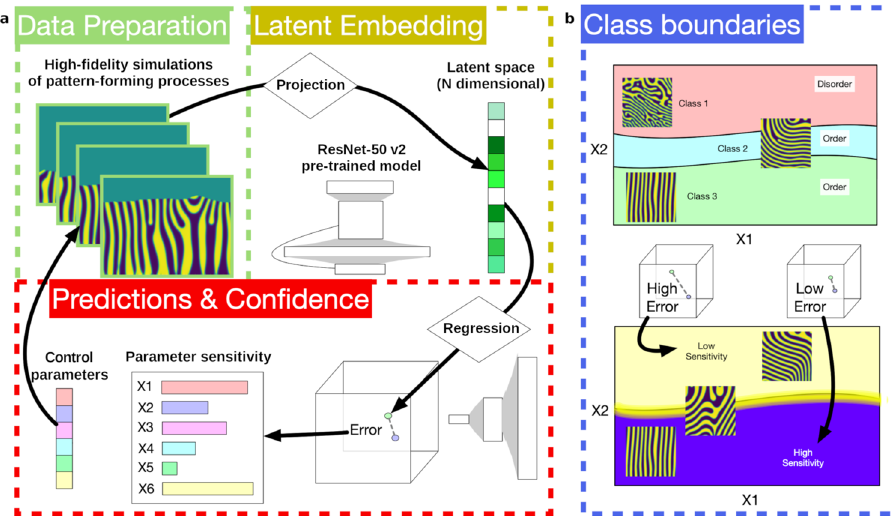
Fig. 1 Work fl ow to identify transition regimes in pattern-forming processes via self-supervised learning. a We simulate the dynamical evolution of the physical system for a broad range of process parameters. Next, we project the fi nal state of the microstructural pattern into a latent space (using a pre-trained ResNet-50 v2 35 ). We regress on these latent dimensions to estimate the original process parameters. b To detect speci fi c classes of microstructural patterns, we evaluate the model error by predicting the corresponding initial process parameters. By measuring the change in sensitivity of forming speci fi c patterns for various input process parameters, we learn where the transition regime(s) might